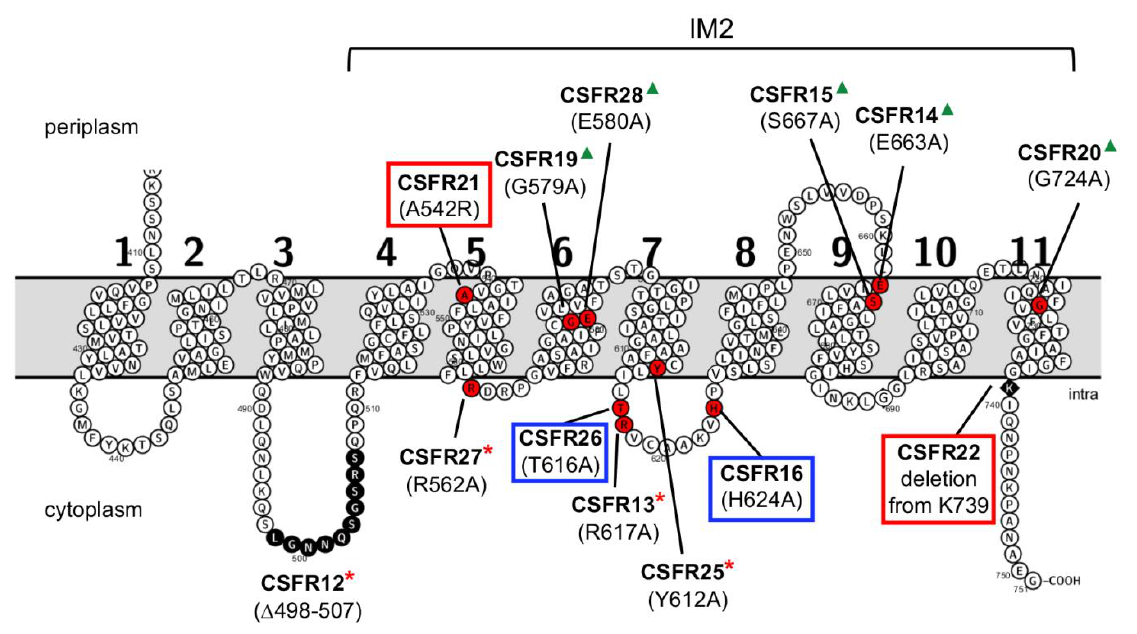
FIGURE 2: Schematic of the permease domain of SepJ from Anabaena sp. PCC 7120 indicating the mutations introduced in this work. Transmembrane segments are numbered 1 to 11 according to the prediction of the TMHMM program. The last eight TMSs are strongly conserved in SepJ proteins constituting subdomain IM2 (see Fig. S1). Because there is strong evidence for a cytoplasmic C-terminus [18, 27], the showed topology is very likely to be correct for subdomain IM2. Red circles, individual amino acids mutated; black circles, residues deleted in strain CSFR12; black rhomboid, residue at which a C-terminal deletion started. Group 1 mutations are framed in red; group 2 mutations are framed in blue; group 3 mutations are indicated by red asterisks; group 4 mutations are indicated by green